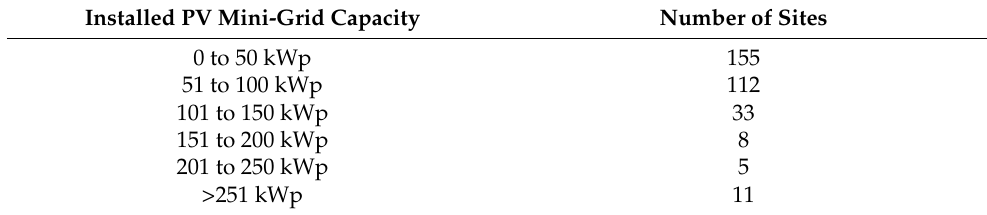
Table 1. Number of mini-grids listed by installed PV capacity in